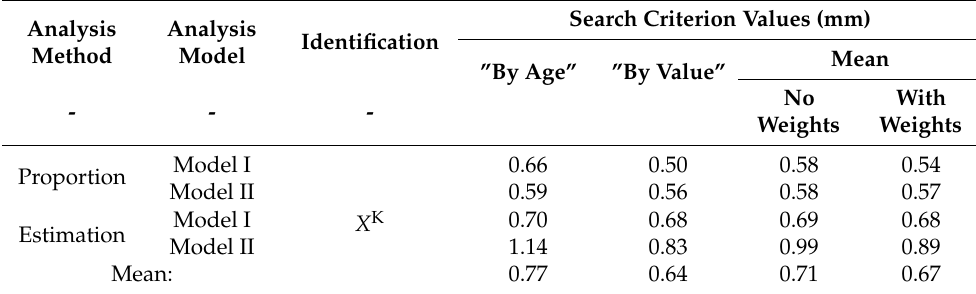
Table 10. Search criterion values for asphalt